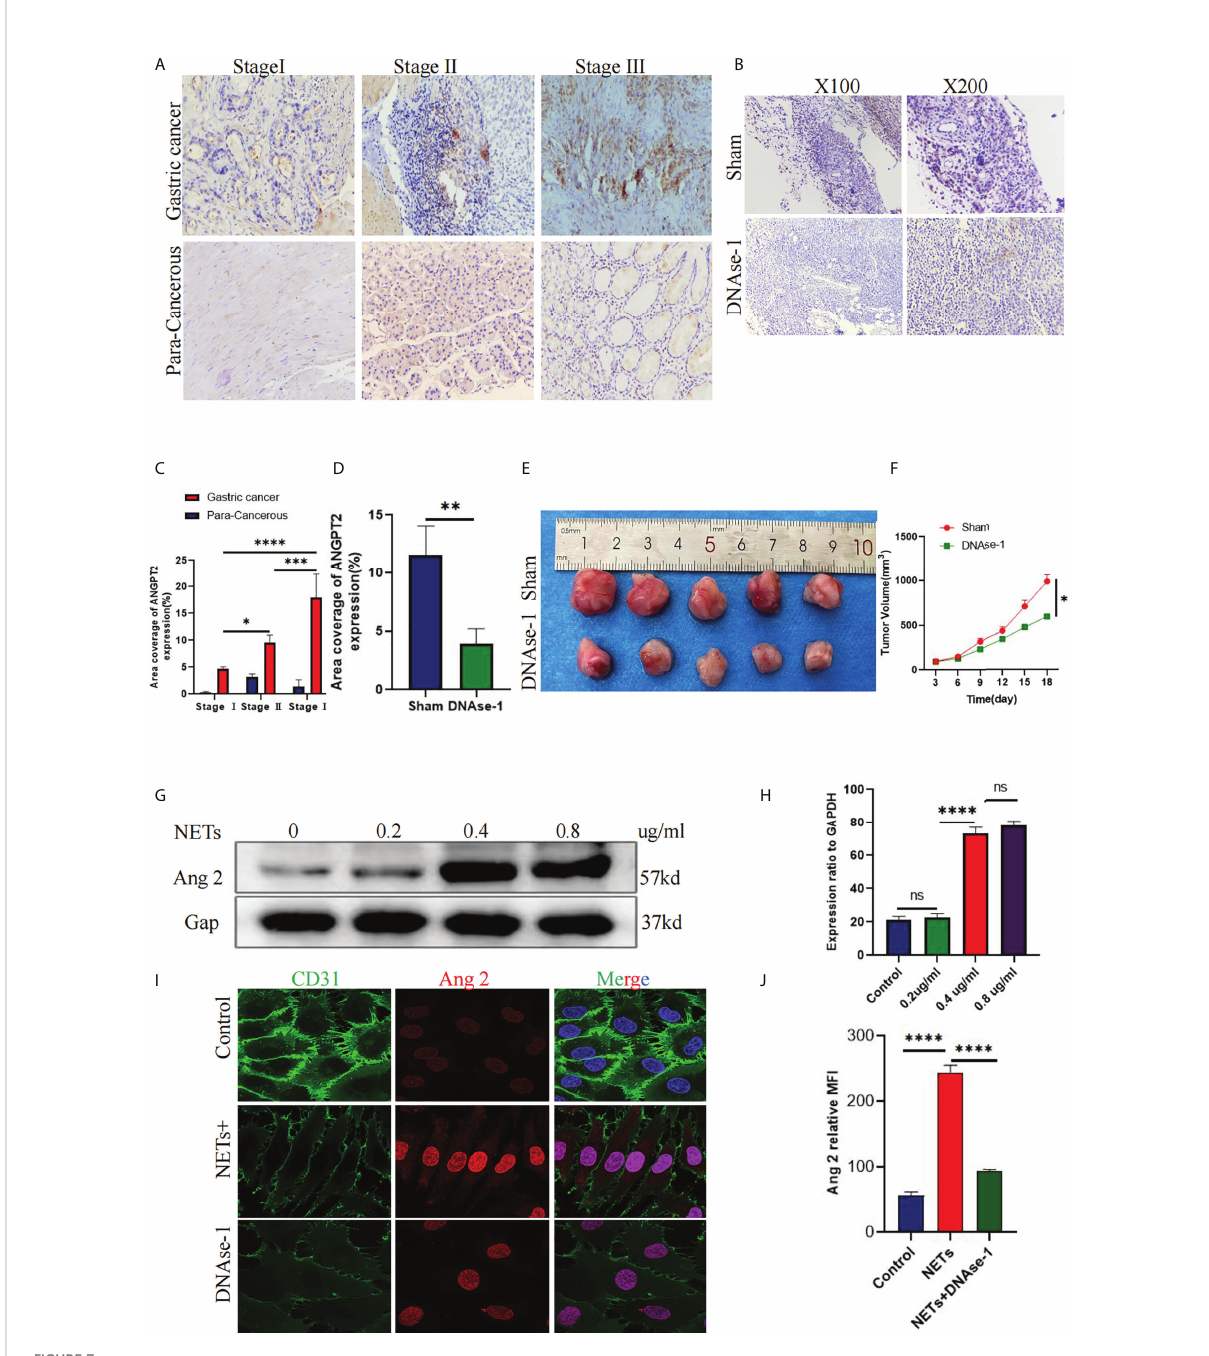
FIGURE 7 ANGPT2 expression in NET-stimulated HUVECs. (A) Immunohistochemical analysis of ANGPT2 expression in gastric cancer and paracancerous tissues of different stages. (B) ANGPT2 expression in mouse subcutaneous tumor tissue was analyzed by immunohistochemical staining. (C) Quantitative analysis of ANGPT2 in gastric cancer and paracancerous tissues. (D) Quantitative analysis of ANGPT2 in mouse subcutaneous tumor tissues. (E) Subcutaneous tumor samples from nude mice treated with DNAse-1 and control group, n=5. (F) Growth curve of subcutaneous tumor in nude mice, all values are mean ± SD. *p < 0.05 by two-way ANOVA. (G) Western blot analysis of ANGPT2 expression after HUVECs were stimulated by different concentrations of NETs. (H) Quantitative analysis of mRNA of ANGPT2. (I) ANGPT2 expression in HUVECs stimulated by PBS, NETs, and NETs+DNAse-1 was analyzed by immuno fl uorescence. (J) Tthe expression is indicated as the mean fl uorescence intensity (MFI),analyzed with Image J software. All values are mean ± SD. ****P < 0.0001, ***P < 0.001,** P < 0.01, *P < 0.05 and ns, not signi fi cant by one-way